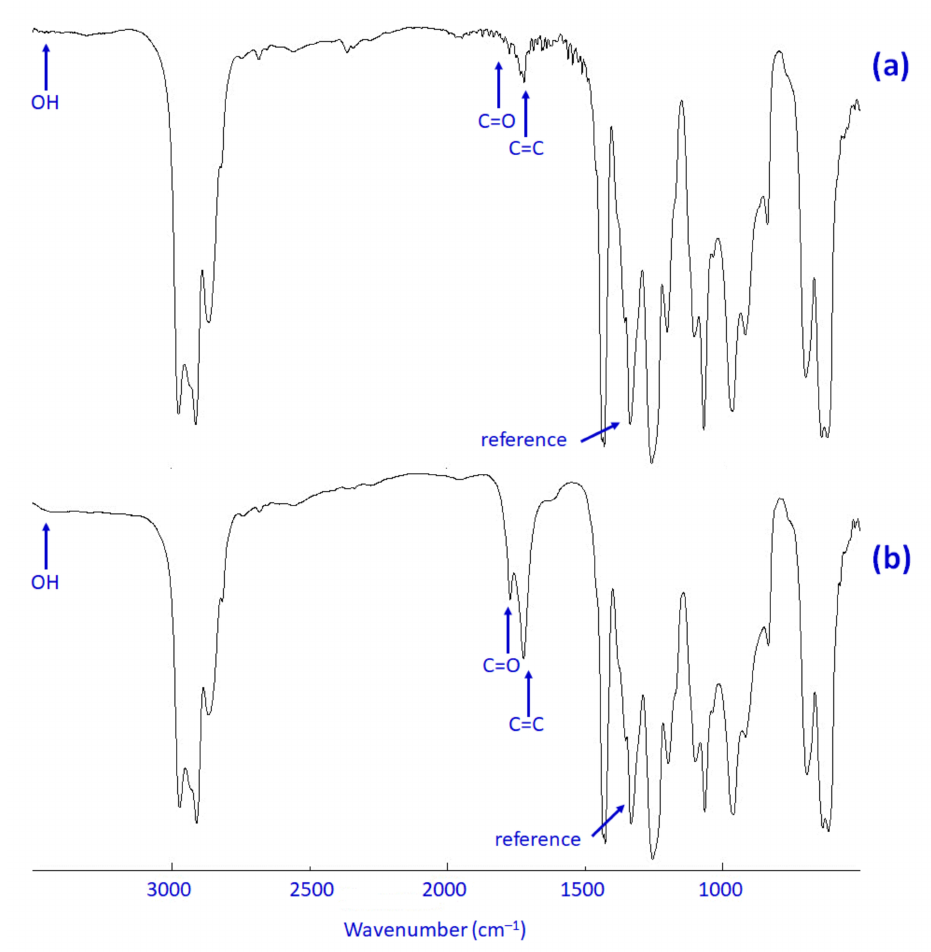
Figure 2. FTIR spectra of pure PVC ( a ) before and ( b ) after irradiation.